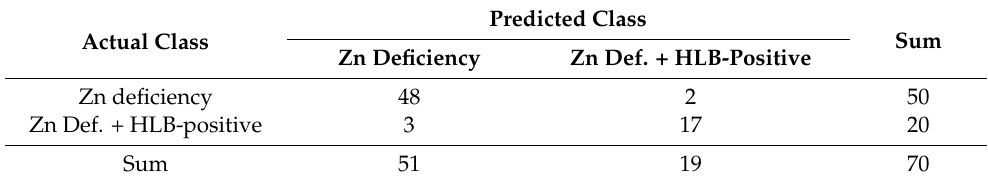
Table 5. Confusion matrix for the identification results of Zn-deficient + HLB-positive samples. Actual